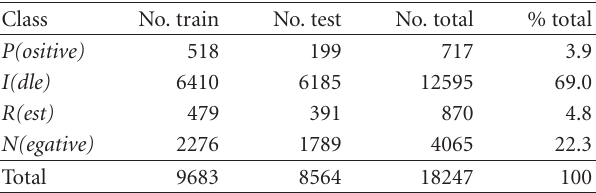
Table 5: Emotion classes and their EC-based